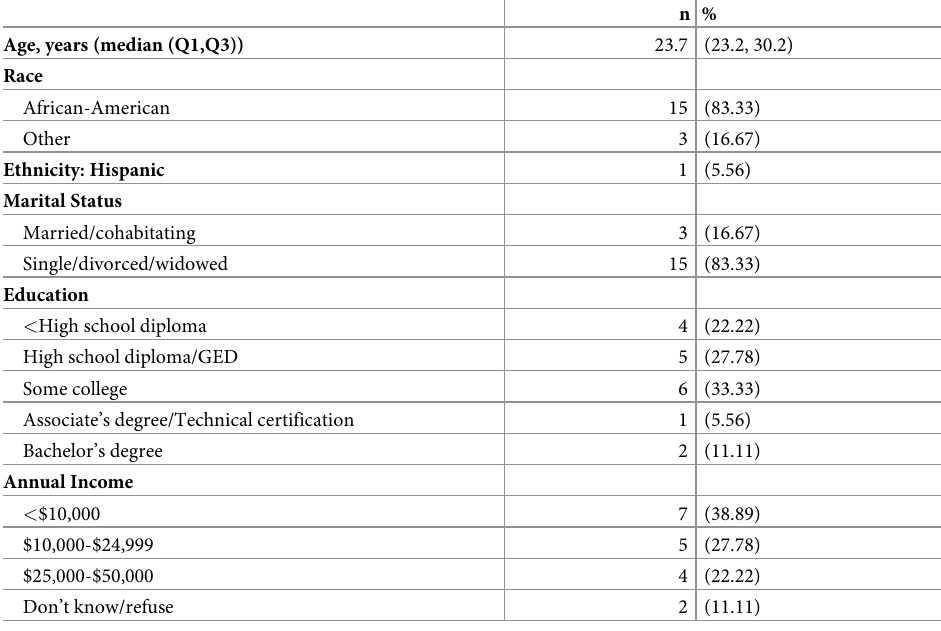
Table 1. Cohort characteristics of n = 18 women enrolled in